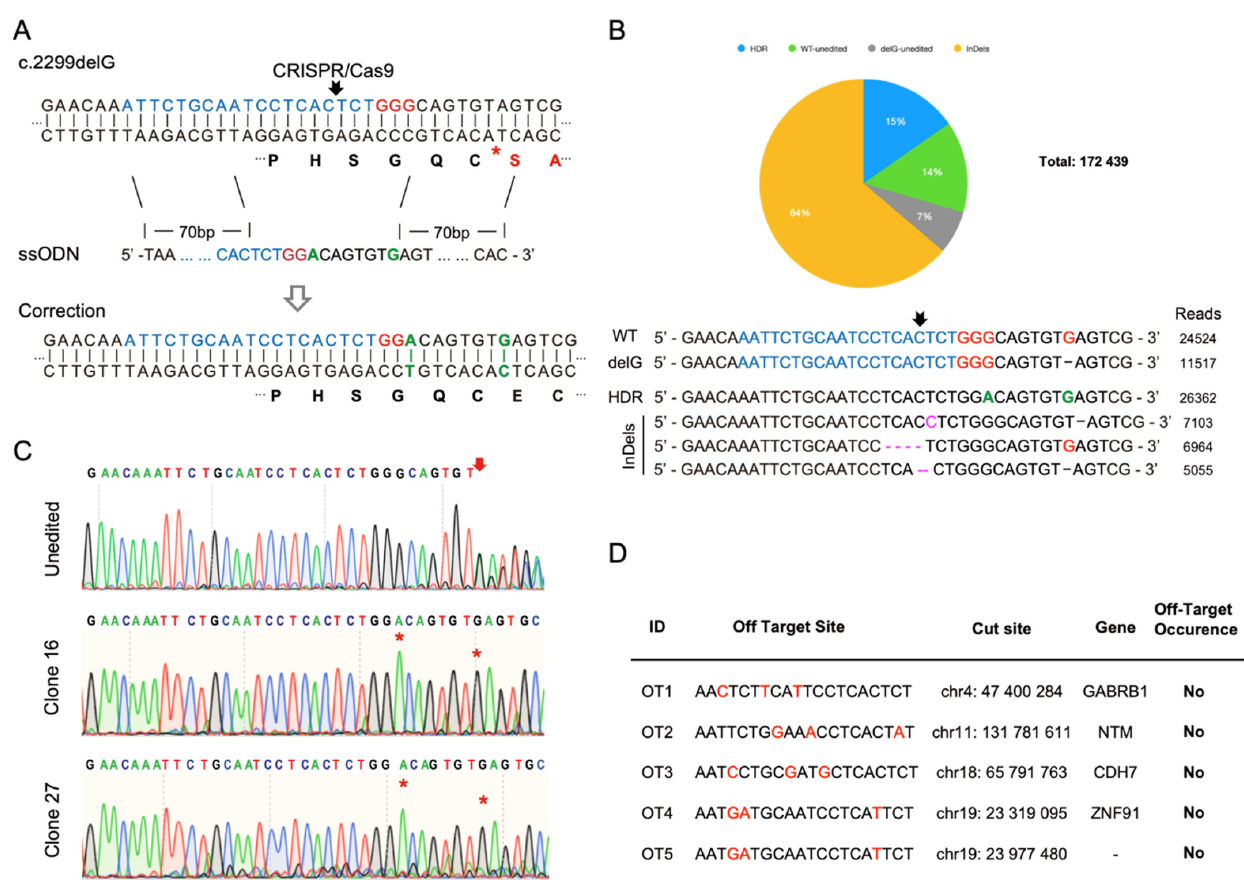
Figure 3. Analysis of CRISPR/Cas9-mediated homology-directed repair for USH2A 2299delG mutation. ( A ) Schematic outline of genetic correction using gene editing. Patient-derived USH2A c.2299delG iPSCs were treated with CRISPR/Cas9 reagents and a single strand homologous repair template. The 20 nt sgRNA targeting site is indicated in blue and the PAM site is indicated in red. Repaired bases in ssODN are indicated in green. The red asterisk indicates the delG mutation site. ( B ) Analysis of the next generation sequencing (NGS) results and demonstration of representative sequence reads for USH2A c.2299delG iPSCs after genetic correction. The gRNA sequence is indicated in blue and the PAM site in red. Repaired bases are indicated in green. InDels are indicated in magenta. ( C ) Sanger sequences of unedited USH2A c.2299delG iPSCs and clone 16, 27 after HDR genetic correction. Genomic DNAs of different clones were extracted for PCR using specific primers flanking c.2299delG. Red arrowhead indicates the delG mutation site and red asterisks indicate the G that was added back as well as a G-to-A flip in the PAM site. ( D ) Off-target study of CRISPR/Cas9-mediated homology-directed repair of c.2299delG mutation. The top potential off-target sites of our gRNA are listed, and the mismatched base is marked in red.